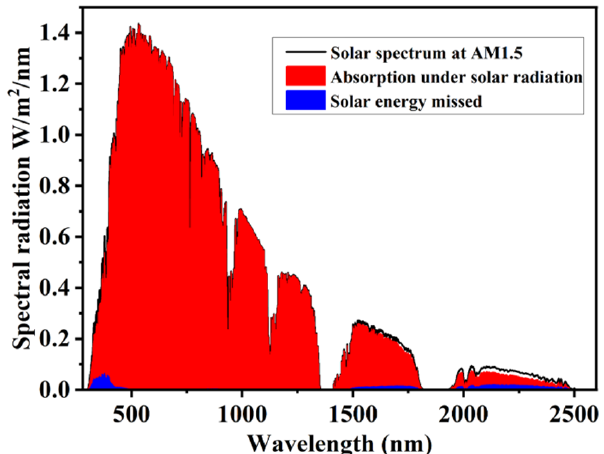
Figure 3. Absorption and unabsorbed energy under a solar spectrum at AM 1.5.